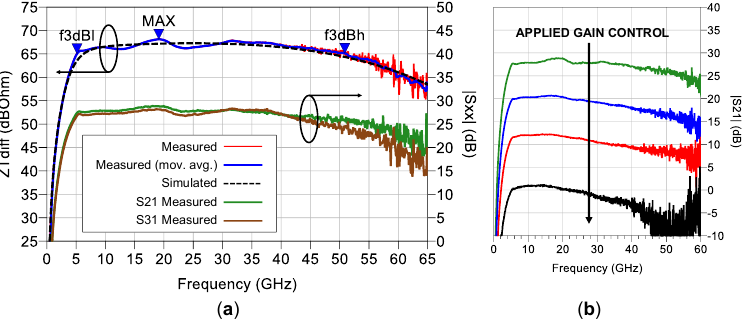
Figure 7. Small signal TIA measurements: ( a ) measured S-parameters (where S 21 and S 31 correspond to the forward transmission coefficients from the input port to each of the differential TIA outputs, cf. Figure 2) and transimpedance response calculated from measurements, compared to simula- tion results; ( b ) effect of the gain control functionality on the S-parameter response for one of the TIA outputs.